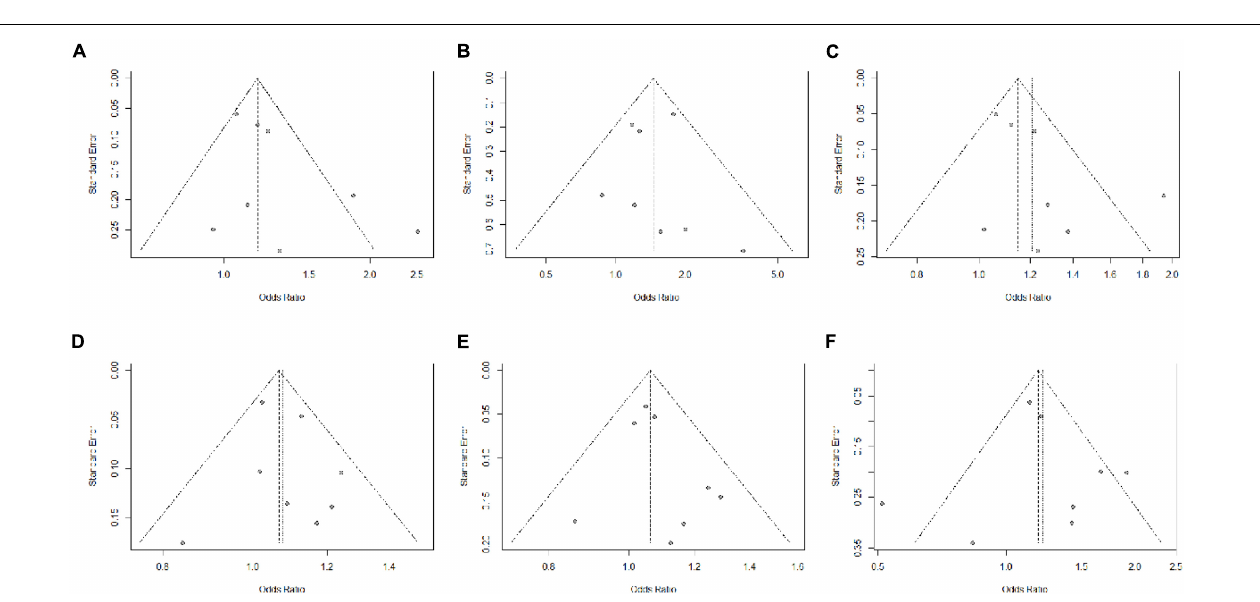
FIGURE 3 | Funnel plots of RA with angina, hypertension, heart attack, abnormalities of heartbeat, stroke, and coronary heart disease. The x-axis represents odds ratio (OR), and the y-axis represents standard error (se). (A) Angina. (B) Hypertension. (C) Heart attack. (D) Abnormalities of heartbeat. (E) Stroke. (F) Coronary heart